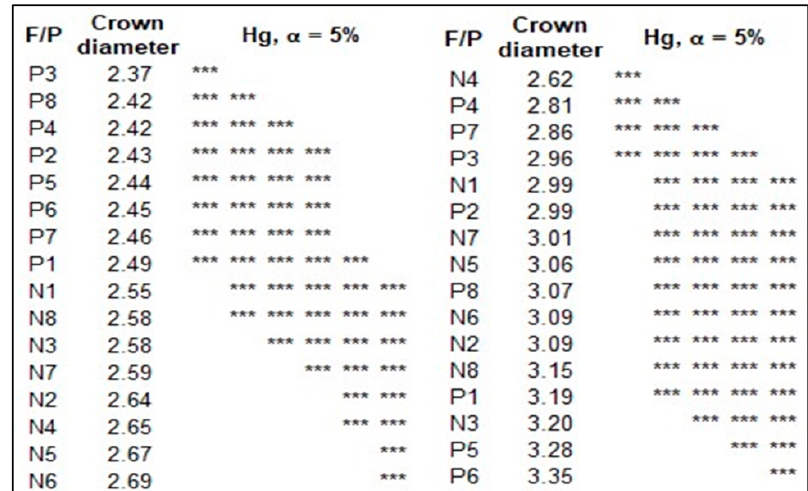
Figure 3. Duncan’s test for crown diameter in the M ă neciu ( left ) and Soveja ( right ) trials. Homogeneous groups (Hg) for α = 5%.